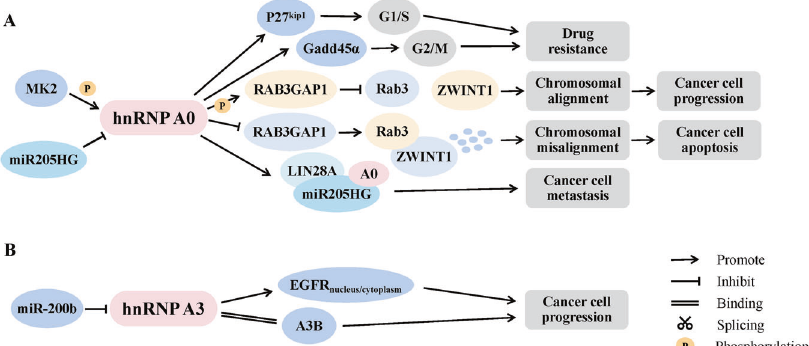
Fig. 1 Mechanisms of hnRNPA0 and A3 in cancer based on available studies. A HnRNPA0 served as a strong promoter for various cancers. MK2-activated hnRNPA0 drove cancer cell drug resistance by regulating p27(Kip1) and Gadd45 α . Meanwhile, phosphorylated hnRNPA0 promoted chromosomal alignment by hindering RAB3GAP1-mediated interaction between ZWINT-1 and Rab3. While, the oncogenic effects of hnRNPA0 could be repaired by lncRNA miR205HG. B HnRNPA3 could facilitate cancer progression by affecting EGFR subcellular localization and binding to A3B. In addition, hnRNPA3 was a negative target of EMT regulator